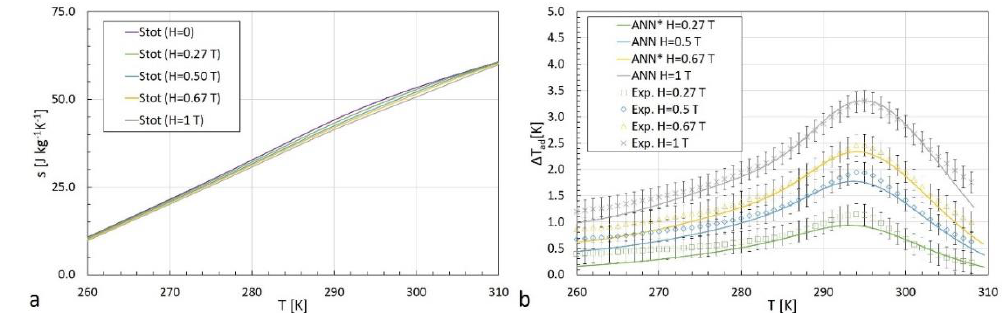
Figure 5. Results of the last step of the procedure: ( a ) s - T diagram of Gd and ( b ) adiabatic temperature change of gadolinium during the magnetisation phase at di ff erent magnetic fields. The asterisk in the legend indicates an applied magnetic field not included in the training dataset.